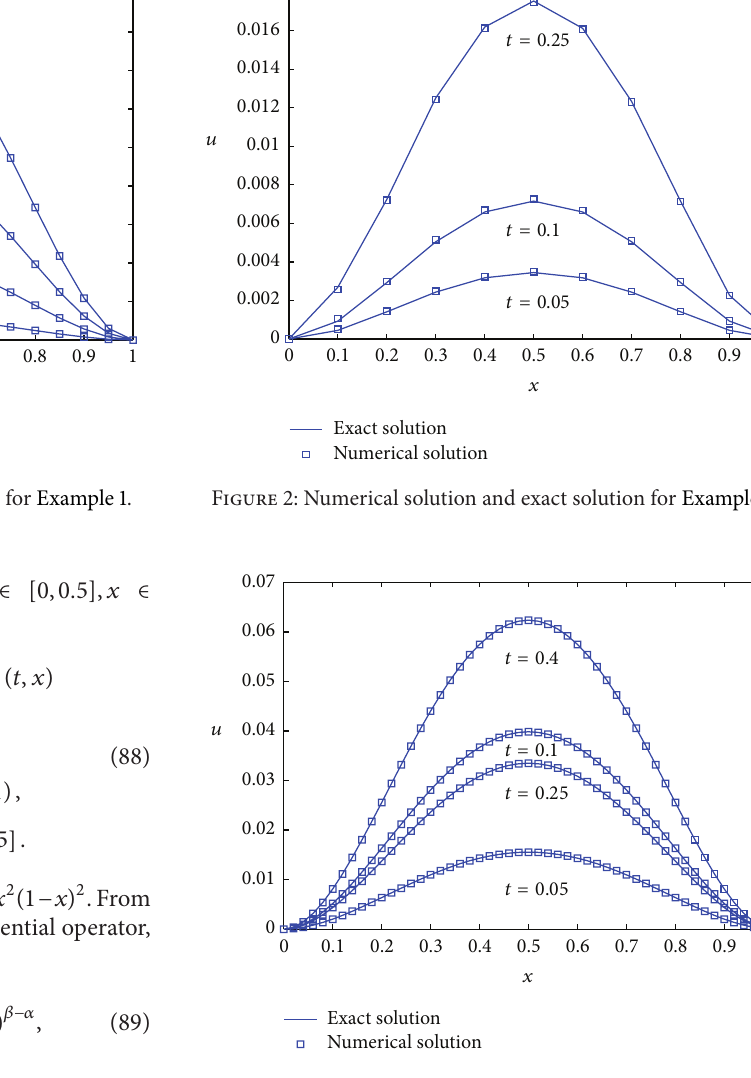
Figure 3: Numerical solution and exact solution for Example